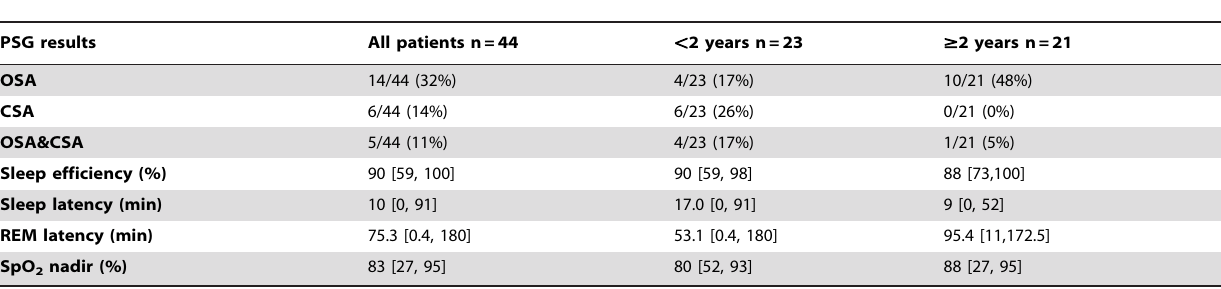
Table 2. Polysomnography Study Data in Children with